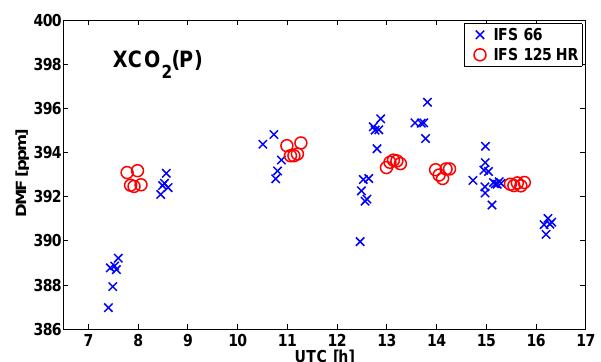
Fig. 2. Individual results for column-average dry-air mole fractions (DMF) of CO 2 , as measured by both instruments for 9 March 2010. The shown values are calculated by ratioing to the surface pressure rather than O 2 , as shown in Fig. 4. The SZAs vary from 78 degrees in the morning to 57 degrees at noon and 82 degrees in the after- noon.